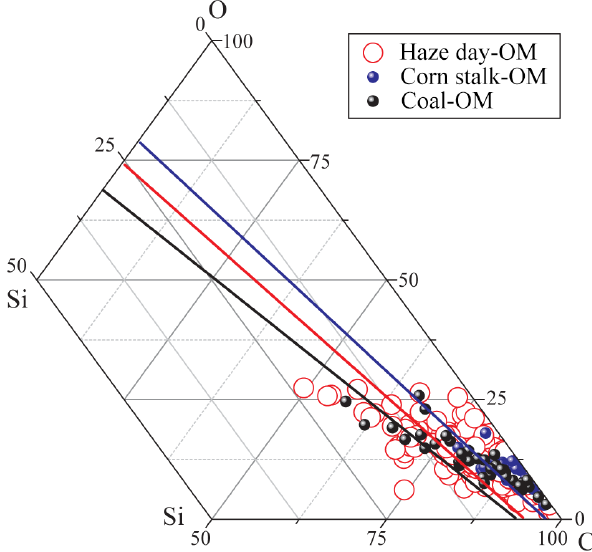
Figure 8. Triangular diagram of weight ratios of Si-O-C based on TEM/EDX data. A total of 39 OM particles are from coal combus- tion and 28 OM particles from corn stalks combustion, as well as 281 OM particles produced from the haze samples in this study. The three lines represent the connection of Si / O and Si / C for different OM particles.